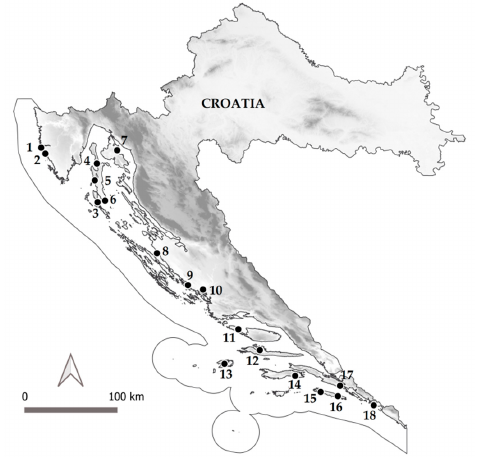
Figure 2. Geographical position of sampled wild strawberry tree ( Arbutus unedo L.) populations in Croatia.